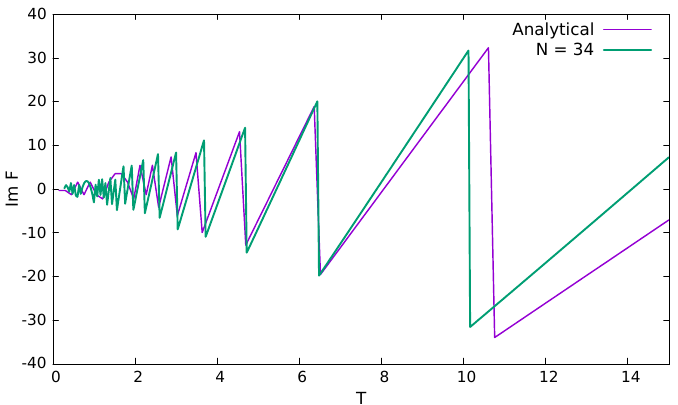
Figure 12: Imaginary part of the free energy for z = 9 e i π/ 6 . We find an excellent agreement with the gravity prediction Eq. (51) with fitting parameters that provide an effective relation between the SYK and the gravity system